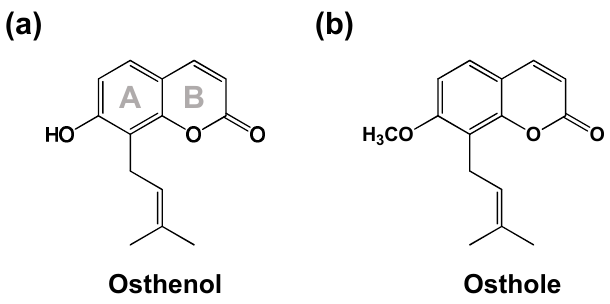
Figure 1. Chemical structures of osthenol ( a ) and osthole ( b ).